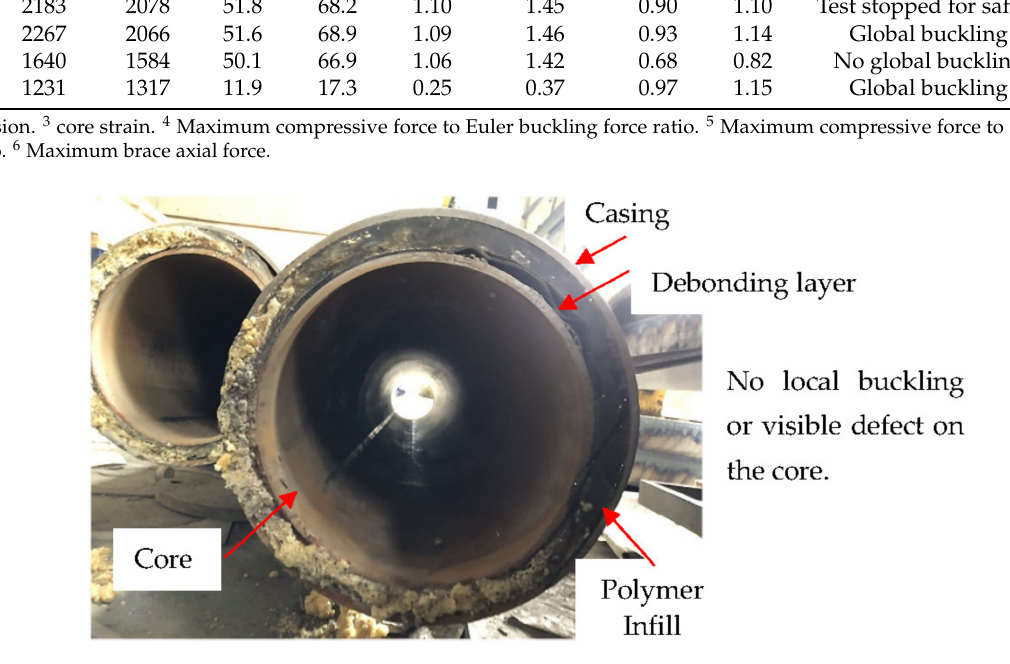
Figure 9. Cross-section of C216 t6–C267 t6-B after water jet cutting.